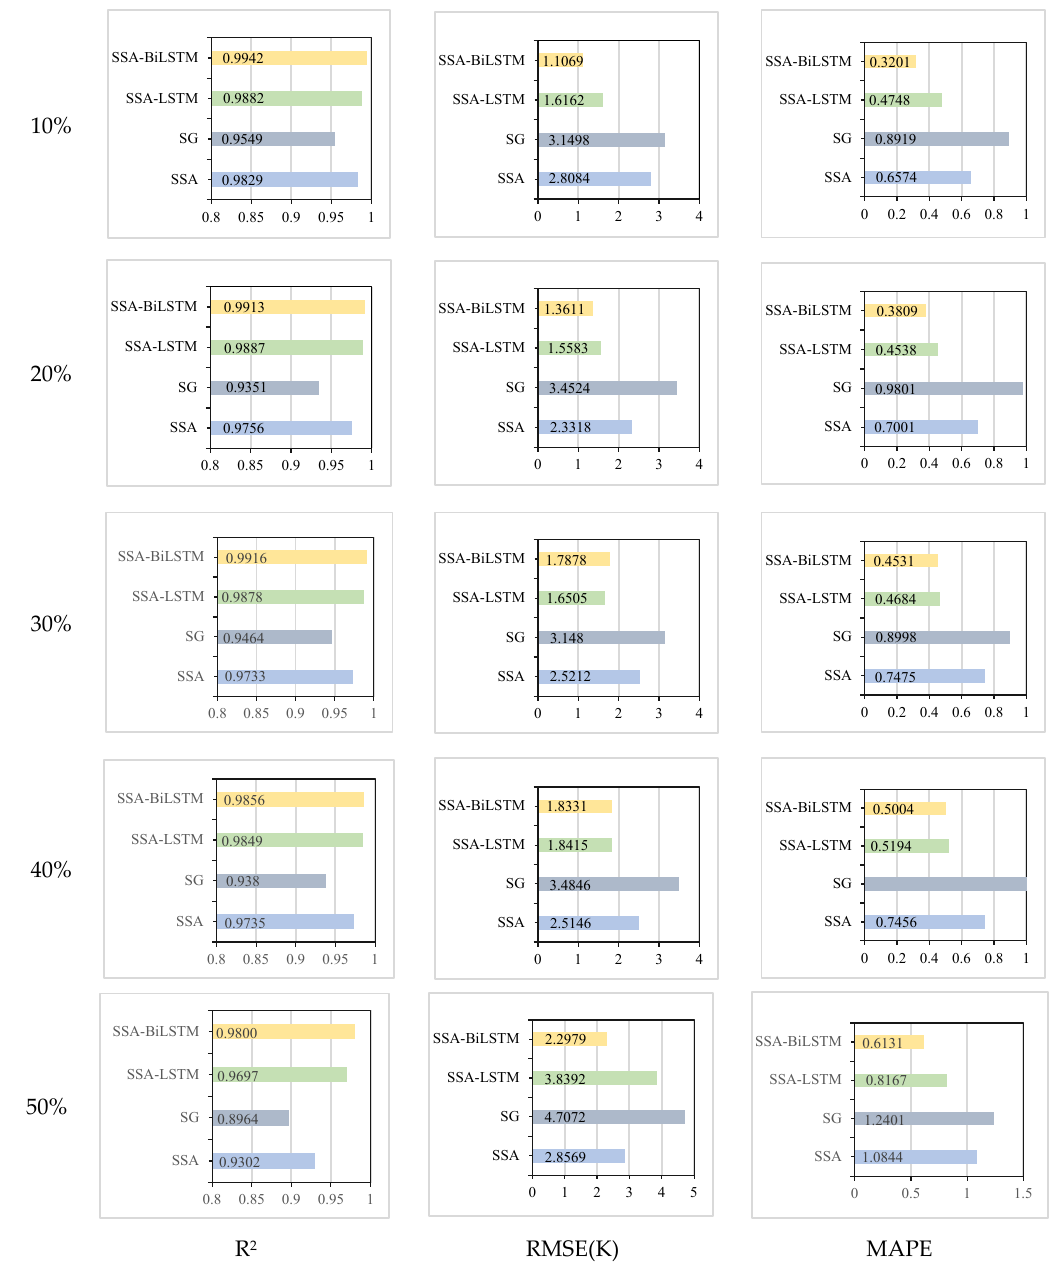
Figure 5. Comparison of the accuracy levels of different LST reconstruction methods at varying missing rates.